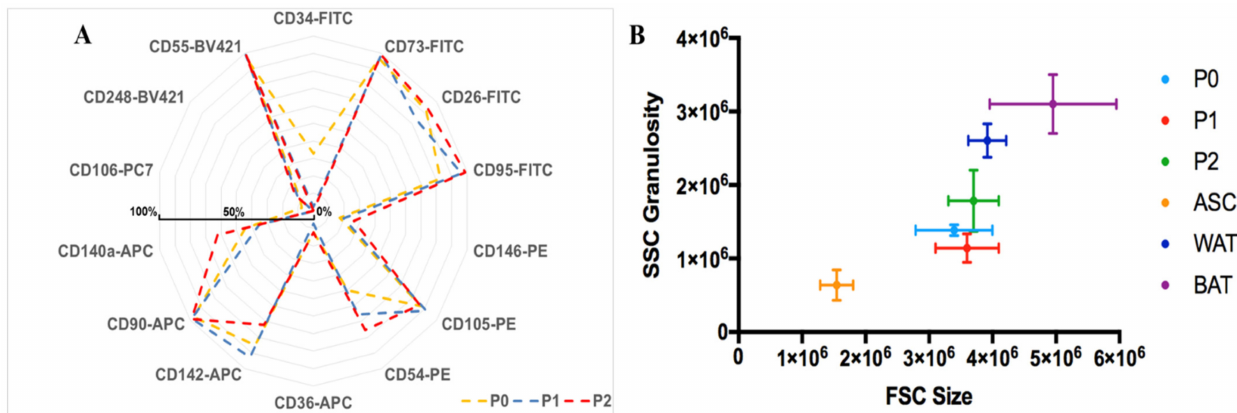
Figure 5. Flow cytometry analysis of cells at P0, P1, and P2 ( A ) Flow cytometry expression profile of selected markers. Data represent an average of three different samples. During culture passaging, the profile of the cells remains similar except for CD34. Data of positive cells are calculated on specific isotype controls. ( B ) Size distribution after isolation, during passages, and after differentiation (FCS: forward scatter and SSC: side scatter). P0, P1, P2: Indication of the passage number of hASCs grown in UrSuppe medium; ASCs found in the SVF as described and explained in Section 3.1; white adipose tissue (WAT) and beige adipose tissue (BAT) represent white or beige induction, respectively. Each point’s coordinate is the mean of three different samples; bars represent standard